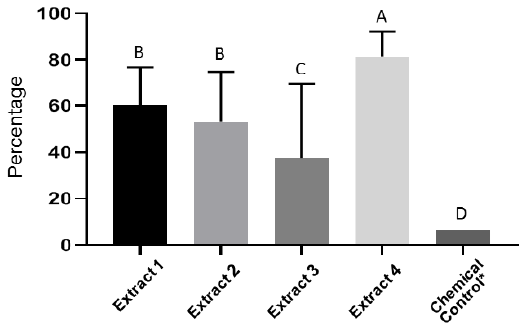
Figure 2. Effect of plant extracts on Forl spore germination. The highest percentage of inhibition was observed in the treatment with extract 4 at 200 g · mL − 1 . Means with different letters indicate significant differences from each other ( p ≤ 0.05).